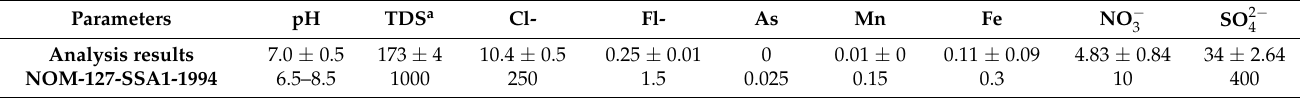
Table 1. Characteristic of studied groundwater. All the concentrations are in mg/L (± standard deviation). Parameters